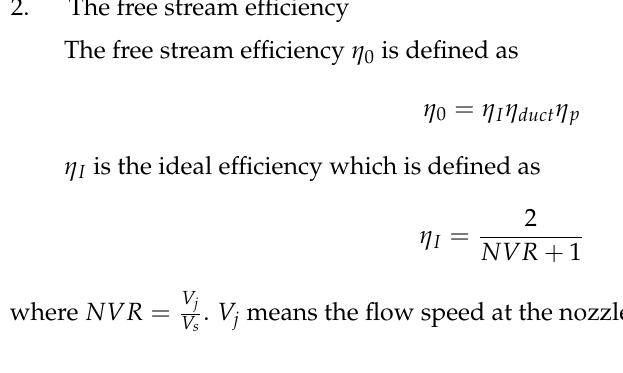
Figure 26. Comparison of the thrust deduction between EFD and CFD.